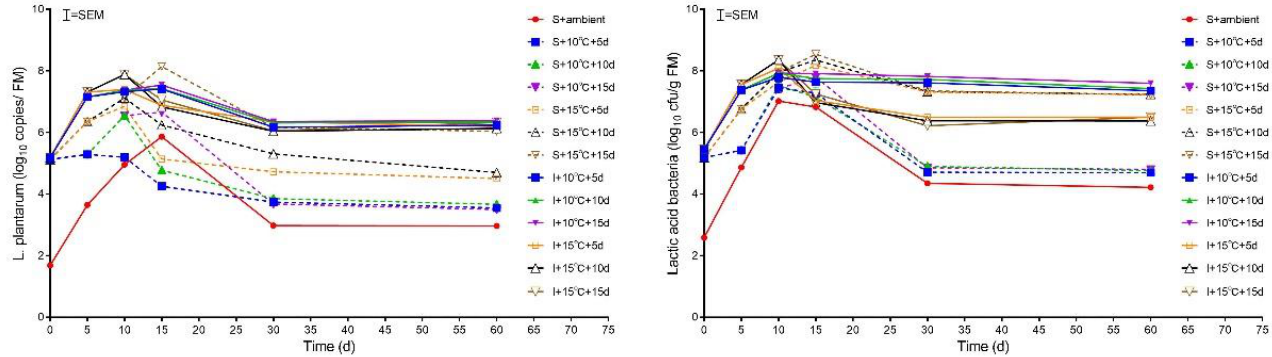
Figure 5. Dynamics of L. plantarum and LAB in silage inoculated with inherent LAB (I) and commercial LAB (S) and stored at ambient temperature and stage-increased temperatures of 10 °C and 15 °C for 5, 10 and 15 days, respectively.